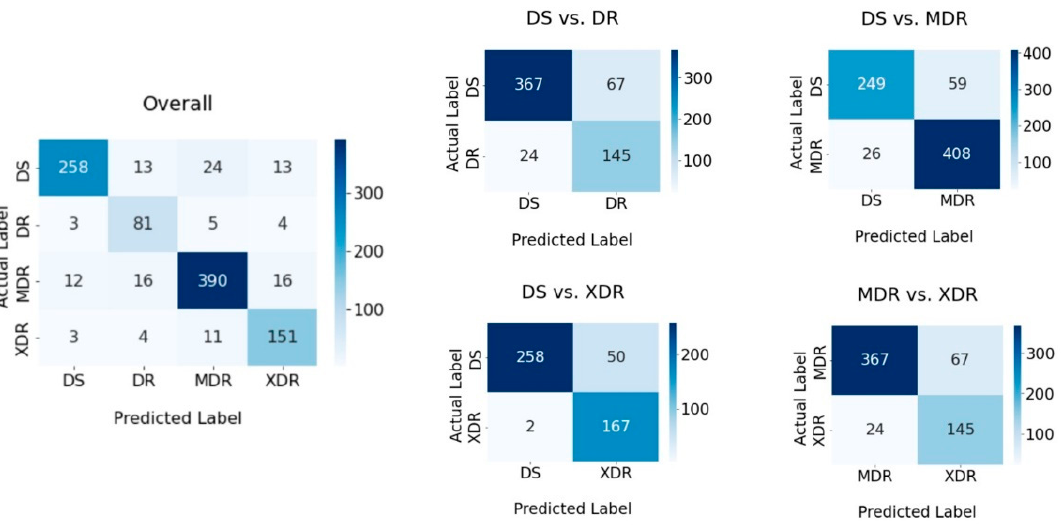
Figure 14. Confusion matrices of the classification result shown in Table 4. Table 6. Multi-Class Classification Result.